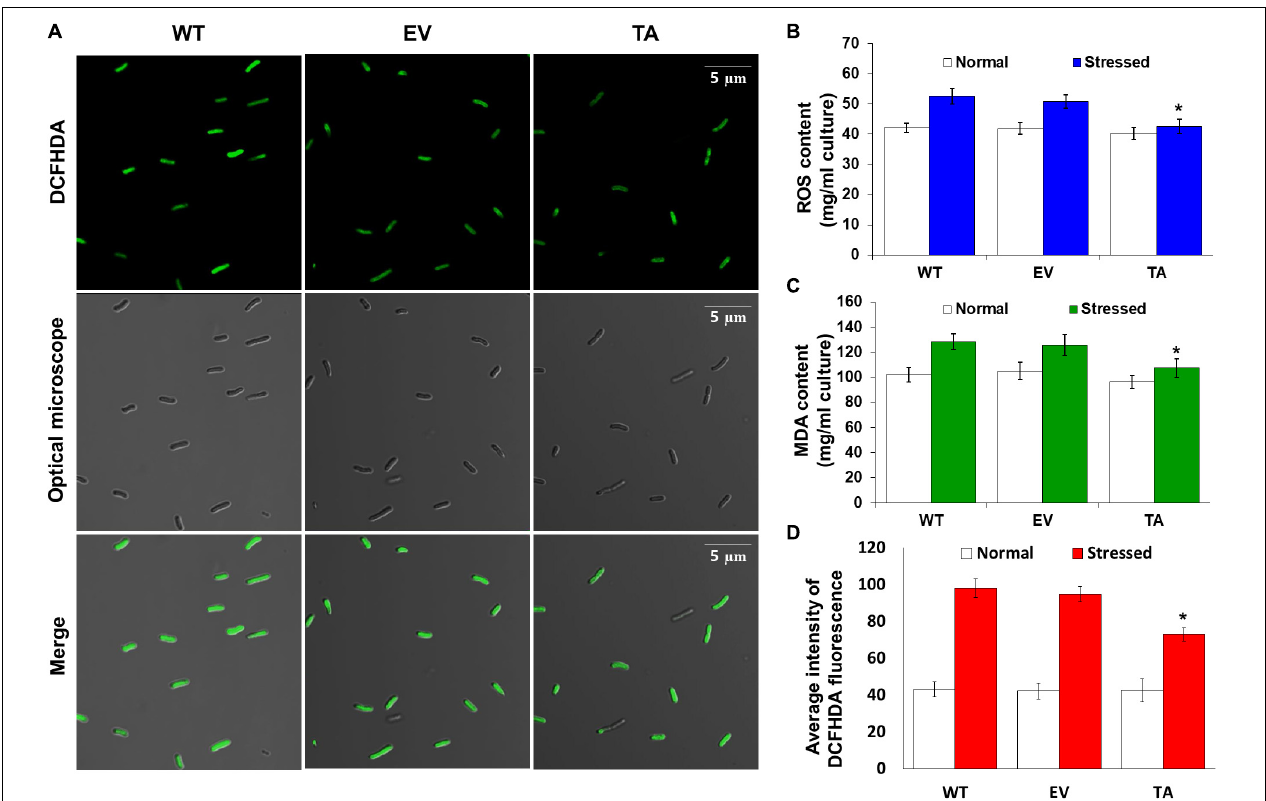
FIGURE 4 | Expression of the OsDHAR gene in S. elongatus PCC 7942 improves intracellular redox homeostasis. (A) Confocal microscopy images of cells stained with DCFHDA to measure levels of ROS after treatment with 2.5 mM H 2 O 2 for 2 h. (B) Intracellular ROS levels were determined using intracellular H 2 O 2 after treatment with 2.5 mM H 2 O 2 for 24 h. (C) Levels of lipid peroxidation were determined by TBA assay using MDA after treatment to 2.5 mM H 2 O 2 -IPTG with 2 mM IPTG for 24 h. (D) DCFHDA fluorescence they also measured ROS production via a microplate reader after treatment with 2.5 mM H 2 O 2 for 2 h. Error bars indicate ± SD of biologically least three independent experiments. Asterisks indicate significant differences between treatments as estimated by Student’s t -test ( P < 0.05).